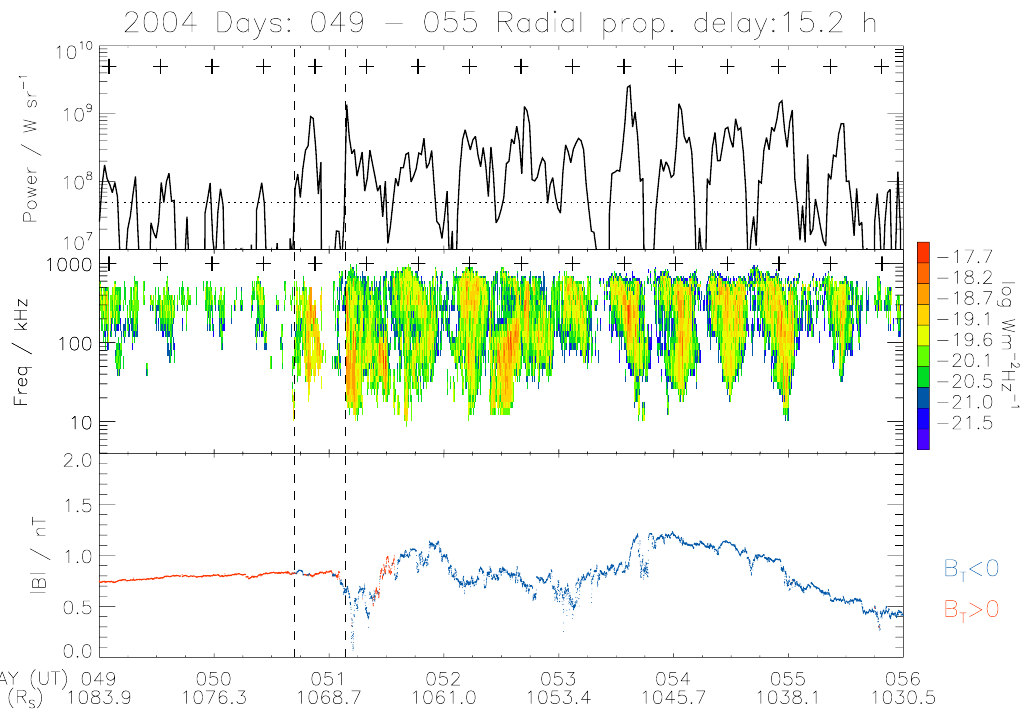
Fig. 1. SKR and IMF data from days 49–55 of 2004. The top panel shows 0.538125h averages of the emitted power of the SKR integrated over 100–300kHz. The crosses toward the top of the panel mark the expected times of the SKR peaks given by Kurth et al. (2007), as described in the text. The middle panel shows the SKR electric field power as a function of frequency and time, colour-coded according to the colour bar at the right hand side of the figure. The crosses on this panel represent the expected peaks of SKR emission, as in the top panel. The bottom panel is a plot of the interplanetary magnetic field strength in nT, colour coded by the sense of the RTN B T component as indicated at the right hand side of the panel. The time axis of these plots is marked in units of days, with sub-divisions every 6h. Also marked is the spacecraft range from Saturn in units of Saturn radii (where 1 R S =60268km). At the top of the plot, an estimate of the solar wind propagation delay is marked, estimated assuming purely radial propagation and a constant solar wind speed of 500kms − 1 . The vertical dashed lines mark features described in the